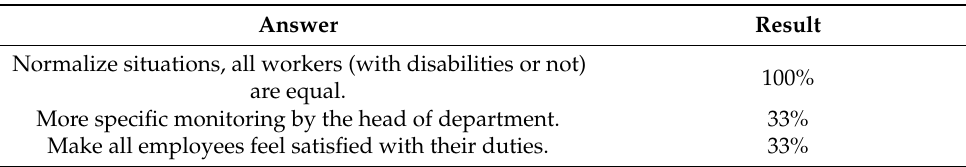
Table 9. What policies do you carry out so that employees with disabilities feel part of the company and thus increase their productivity? Answer Result Normalize situations, all workers (with disabilities or not) 100% are equal. More specific monitoring by the head of department. 33% Make all employees feel satisfied with their duties. 33%